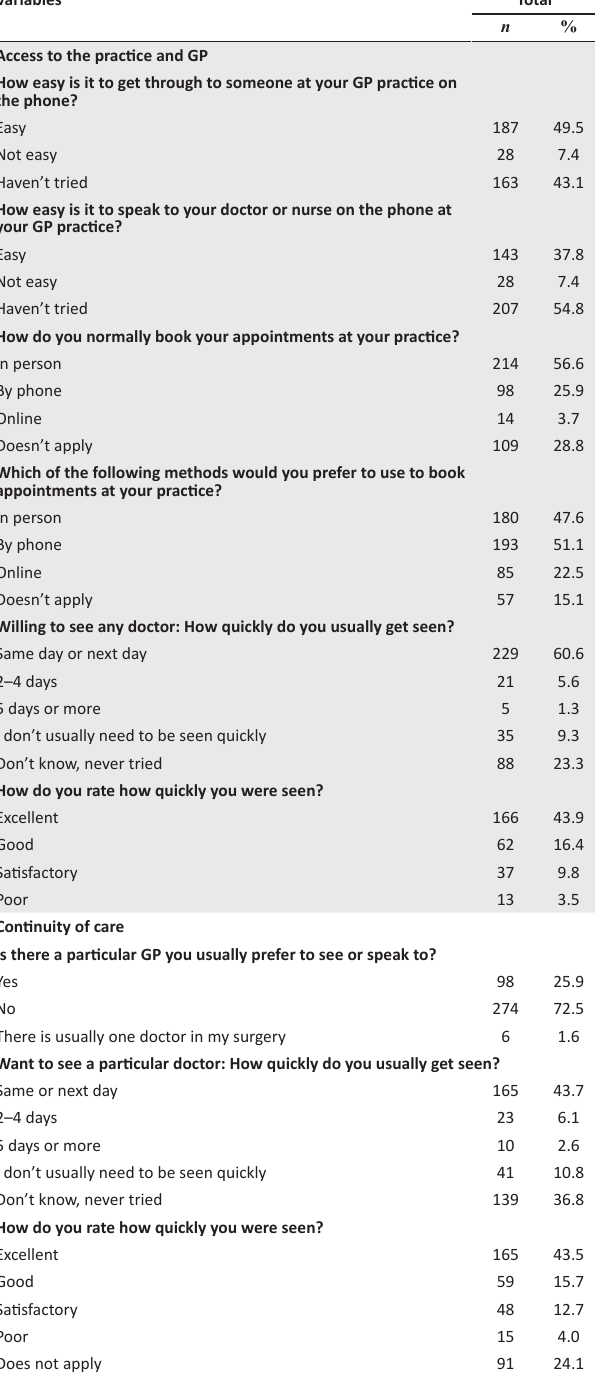
TABLE 4: Access to the practice and general practitioner, and continuity of care ( N = 378). Variables